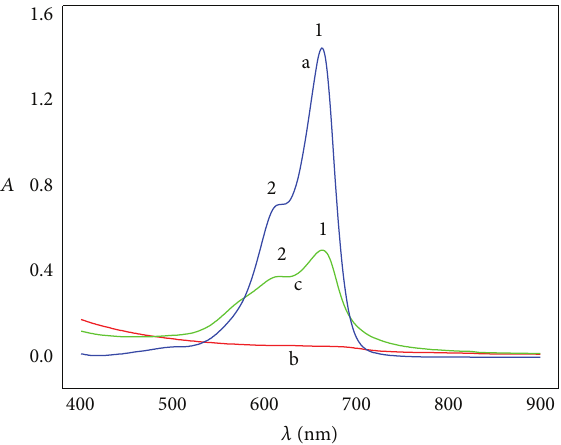
Figure 2: Comparison of UV-visible spectra of MB (a), GO (b), and the mixture solution of MB and GO (c) in 1.0cm light path length cell.